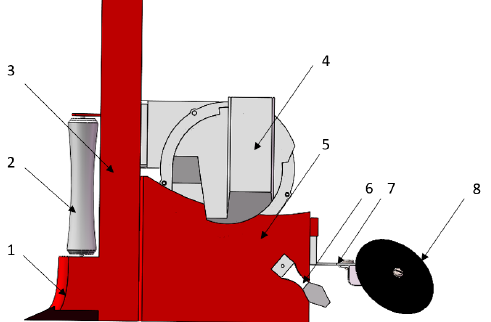
Figure 1. Schematic diagram of the overall structure of the soil-covering device with soil-closing function: 1—opener; 2—anti-blocking roller; 3—share shaft; 4—seed metering device; 5—retaining plate; 6—dividing plate; 7—connection frame; 8—covering disc.